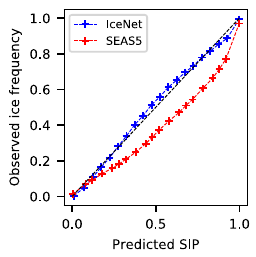
Fig. 6 Calibration curves for IceNet and SEAS5. Observed frequencies of ice (sea ice concentration >15%) are plotted against binned probabilities of the sea ice probability (SIP). IceNet ’ s calibration curve is close to the ideal black dashed line, indicating that IceNet ’ s output probabilities are almost equal to the true likelihood of sea ice occurring. In contrast, SEAS5 overestimates sea ice probability. The calibration curves are computed over the test years 2018 – 2020 and all six lead